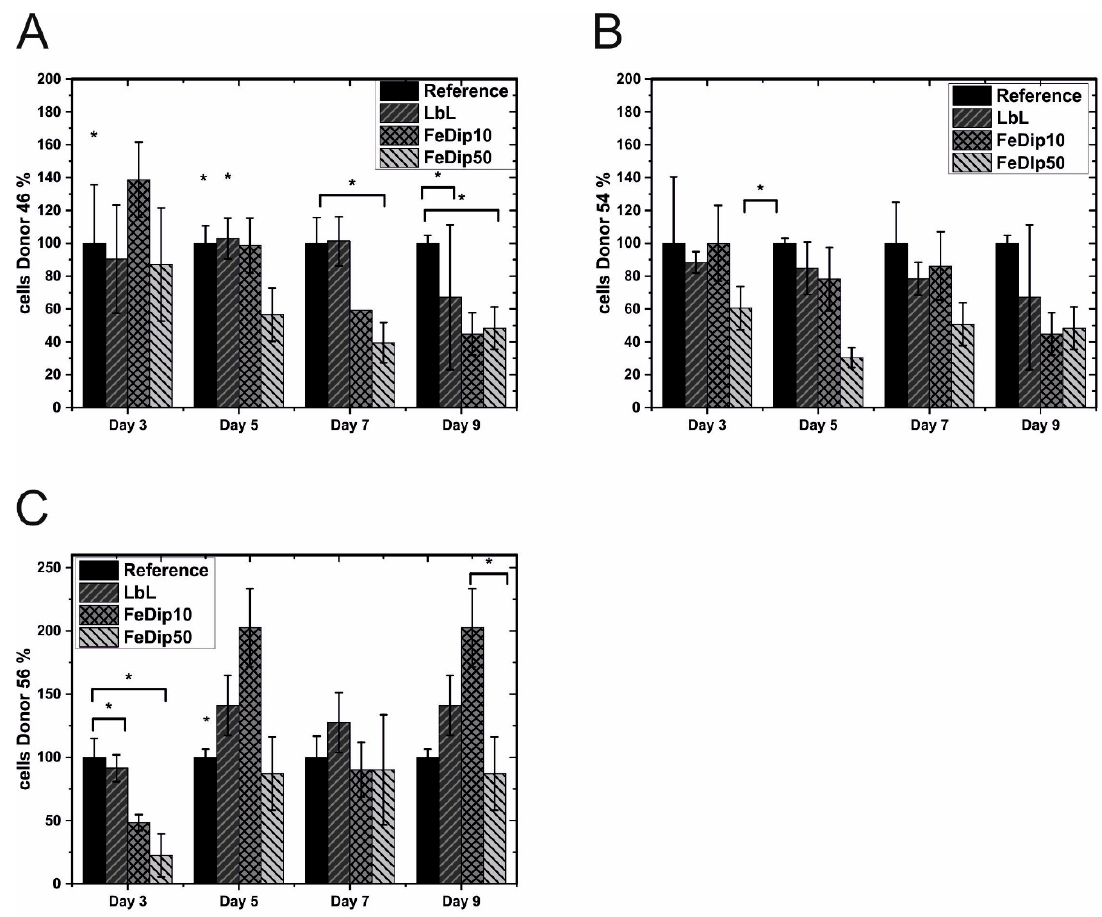
Figure 4. Cell growth of the used bone derived mesenchymal stem cells (BMSCs) from ( A ) Donor 46, ( B ) Donor 54, and ( C ) Donor 56 relative to that on the reference surface for the particular surface modifications at four different time points. All experiments were performed in triplicate. * p < 0.5 (analyzed by one-way ANOVA with Tukey test).